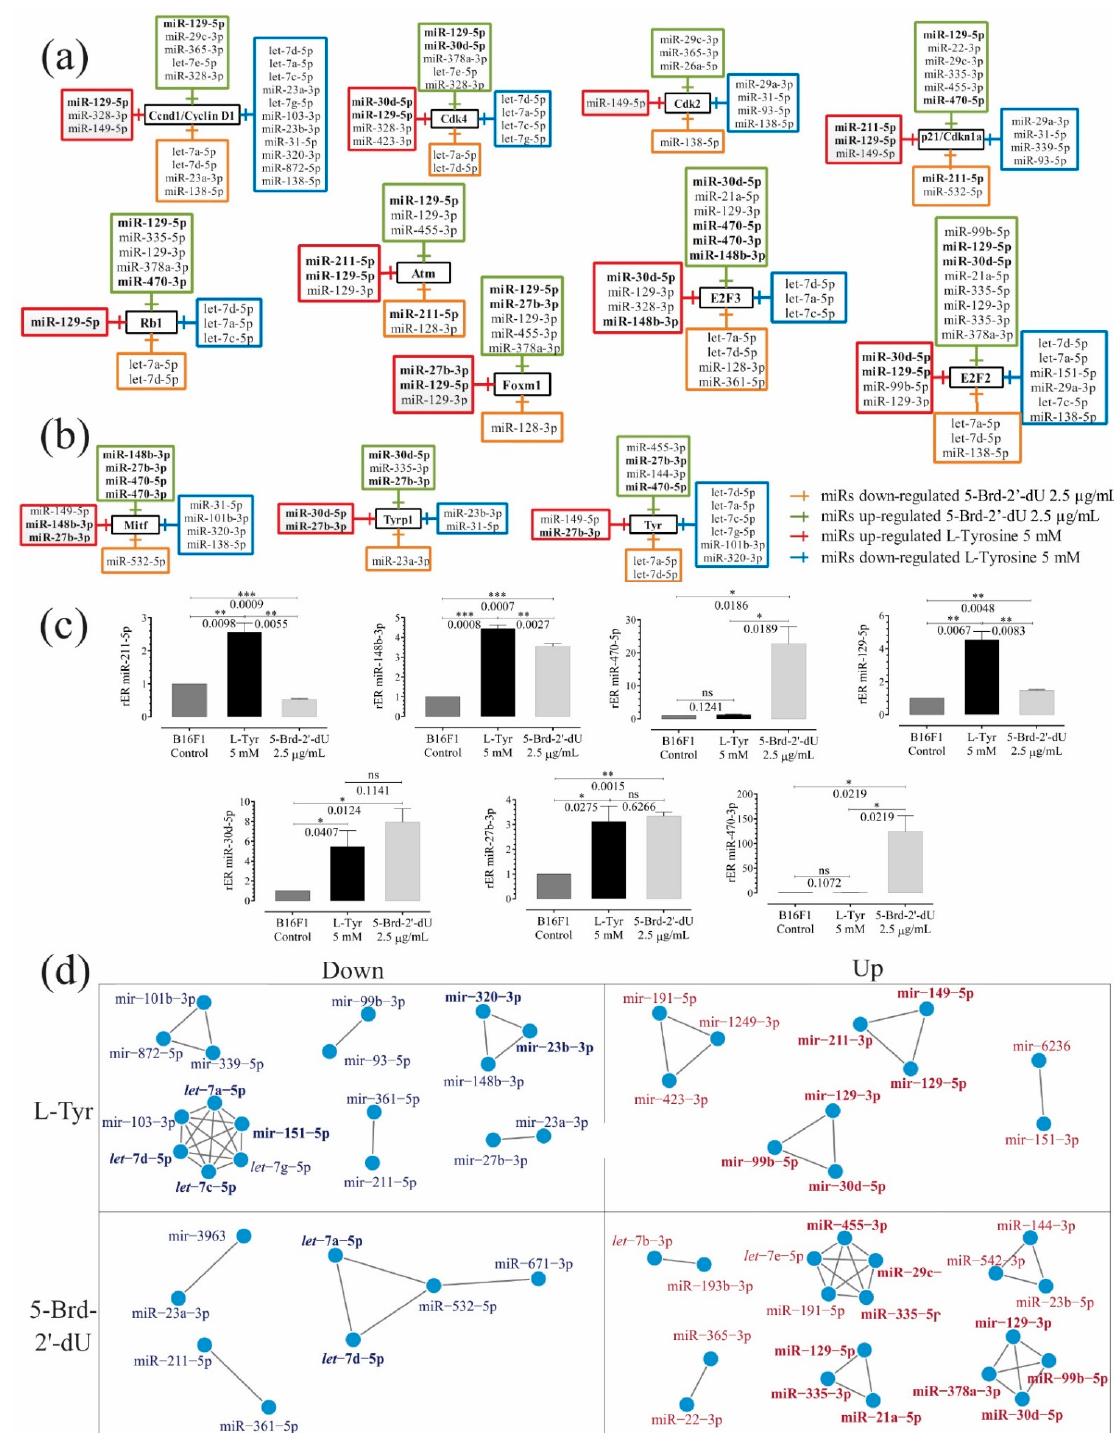
Figure 4. Sets of miRNAs show coordinated expression patterns in the differential pigmentation model and reduced proliferation induced in melanoma B16F1 cells. Sets of over-and under-expressed miRNAs and their potential candidate genes associated with cell cycle and senescence control ( a ) and melanogenesis ( b ) using the TargetScanMouse tool version 7.1. ( c ) Relative expression radius (rER) of miRNAs by RT-qPCR stem-loop for miRNAs 211-5p, 148b-3p, 470-5p, 129-5p, 27b-3p, 470-3p and 30d-5p ( n = 3). ( d ) Co-expression networks from normalized Small RNA-Seq count of under-expressed miRNAs of B16F1 cells exposed to L-Tyr or 5-Brd-2 (cid:48) -dU. The level of significance (*) using two-tailed multiple t -tests. The differences were considered statistically significant for a p -value < 0.05, ns: not significant. Significant (*) with p < 0.05, very significant (**) with p < 0.01, highly significant (***) with p <